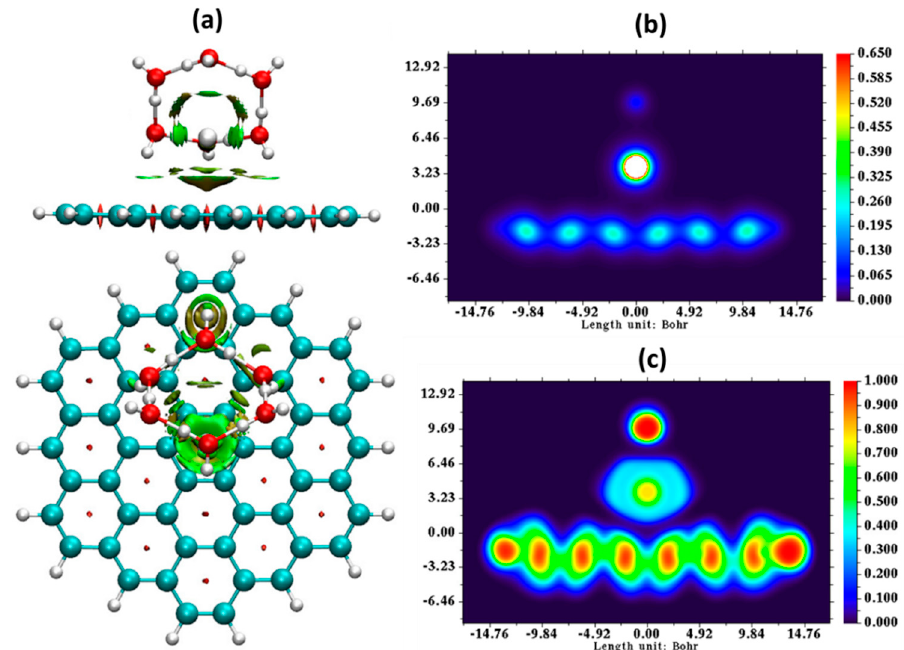
Figure 8. ( a ) Side and top view plots of the noncovalent interaction (NCI) iso-surface (RDG = 0.5) for [Hg(H 2 O) 6 ] 0 on graphene. The iso-surfaces are colored according to sign( λ 2 ) ρ over the range − 0.035 to 0.02 a.u. Red indicates the steric repulsion region; green (light brown) indicates the van der Waals interaction region, and blue implies the strong attractive interaction. Contour plots of the ( b ) electron density and ( c ) electron localization function (ELF) for [Hg(H 2 O) 6 ] 0 adsorbed onto graphene.